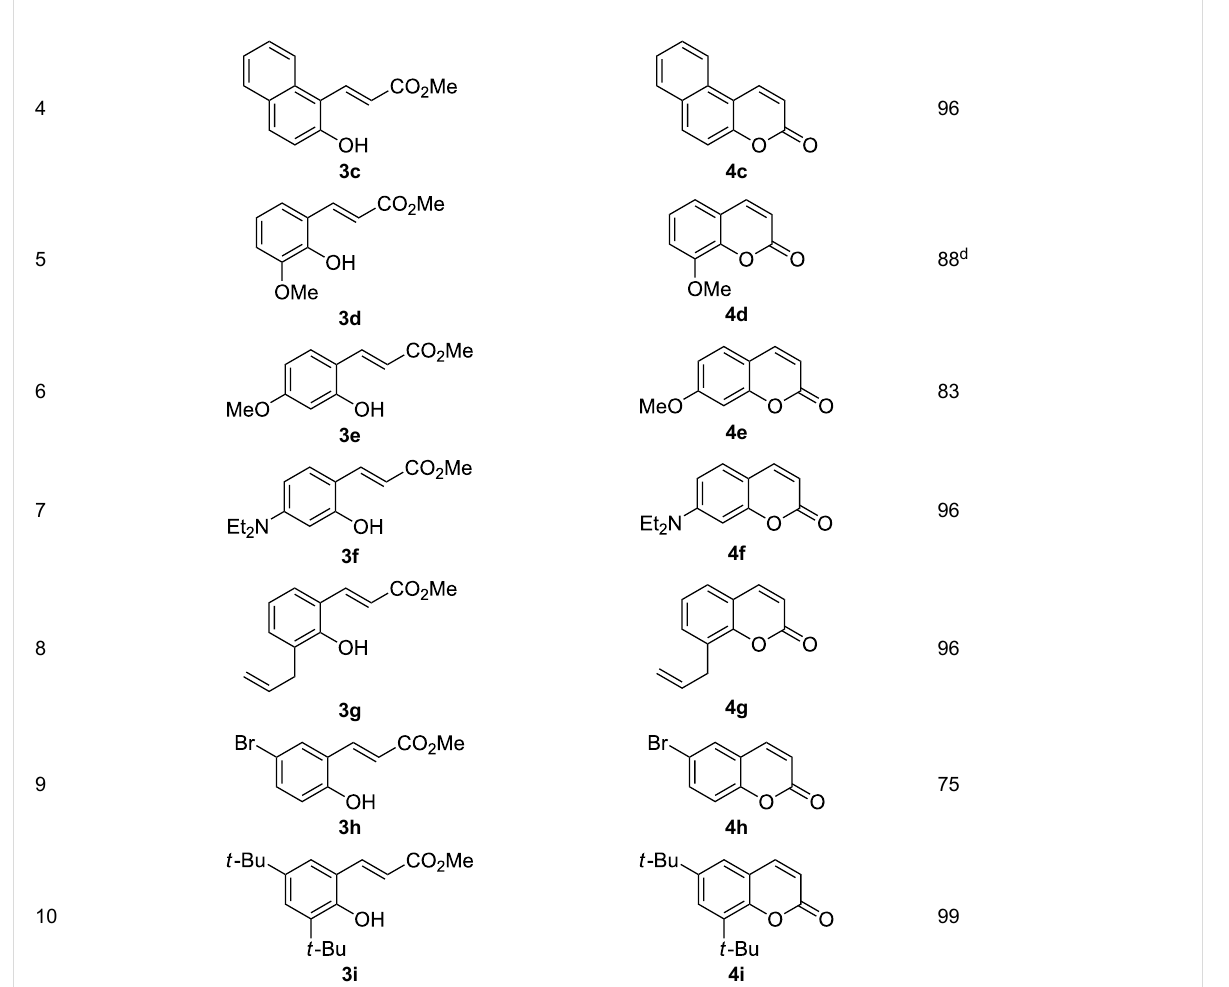
Table 3: Substrate scope of the phosphane catalyzed coumarin synthesis. a